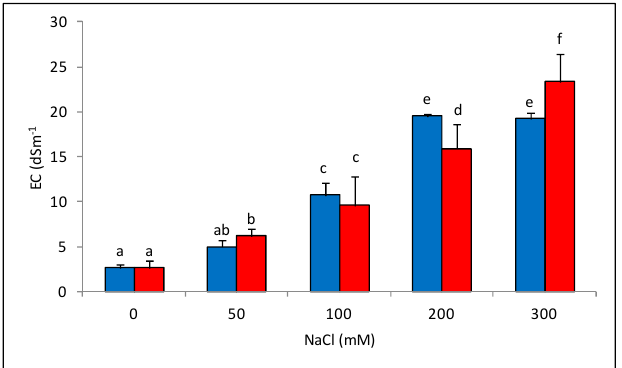
Figure 1. Electrical conductivity (EC 1:5 ) of the pot substrates after 25 days of treatment with the indicated NaCl concentrations, in Solanum melongena (blue) and S. insanum (red). Same letters indicate homogeneous groups between combinations of treatments for EC according to the Tukey test ( p < 0.05, n = 5).